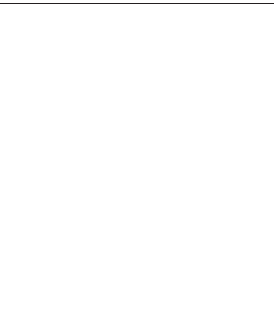
Figure 2. QuarkDB three-node deployment